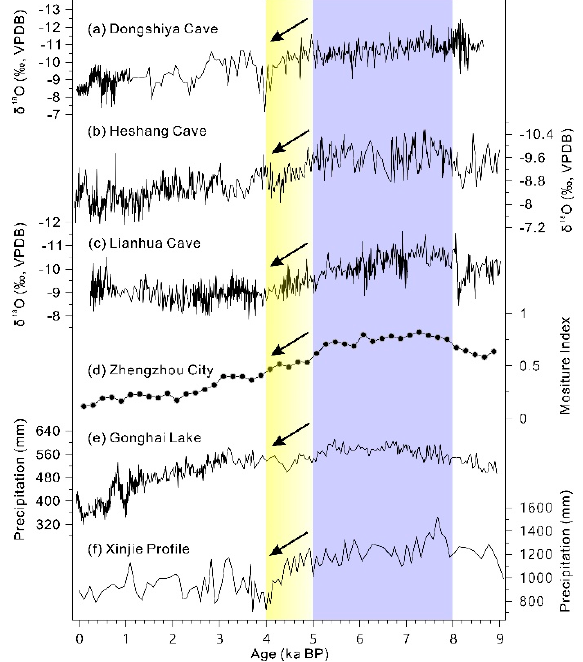
Figure 3. Proxy sequences of climatic changes within and around the study area during the past 9000 years. ( a ): δ 18 O sequences from Dongshiya Cave [47]; ( b ): δ 18 O sequences from Heshang Cave [48]; ( c ): δ 18 O sequences from Lianhua Cave [49]; ( d ): moisture index reconstruction in the Zhengzhou city [50]; ( e ): annual precipitation reconstruction based on pollen assemblages in Gonghai Lake [51]; ( f ): annual precipitation reconstruction based on pollen assemblages in the Xinjie Profile [52].